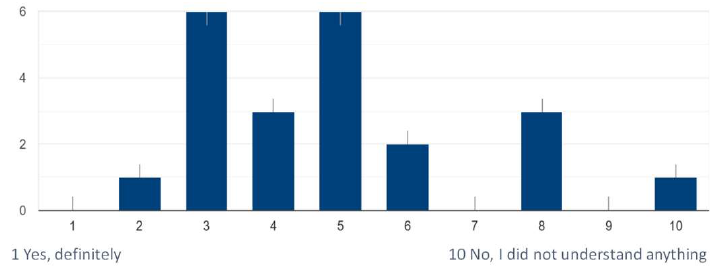
Figure 11: Feedback to the software intuitiveness rated by the